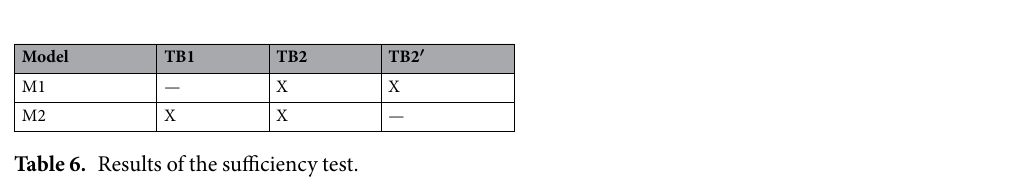
Figure 12. Partial simulation results for the Restart scenario for models M2 and M3. It includes the value history of the 3 first states for M2 and M3 ( a ), the first steps of M2 simulation in agreement with TB2 ( b ), and the first steps of M3 simulation in agreement with TB2 and TB2 ′ ( c